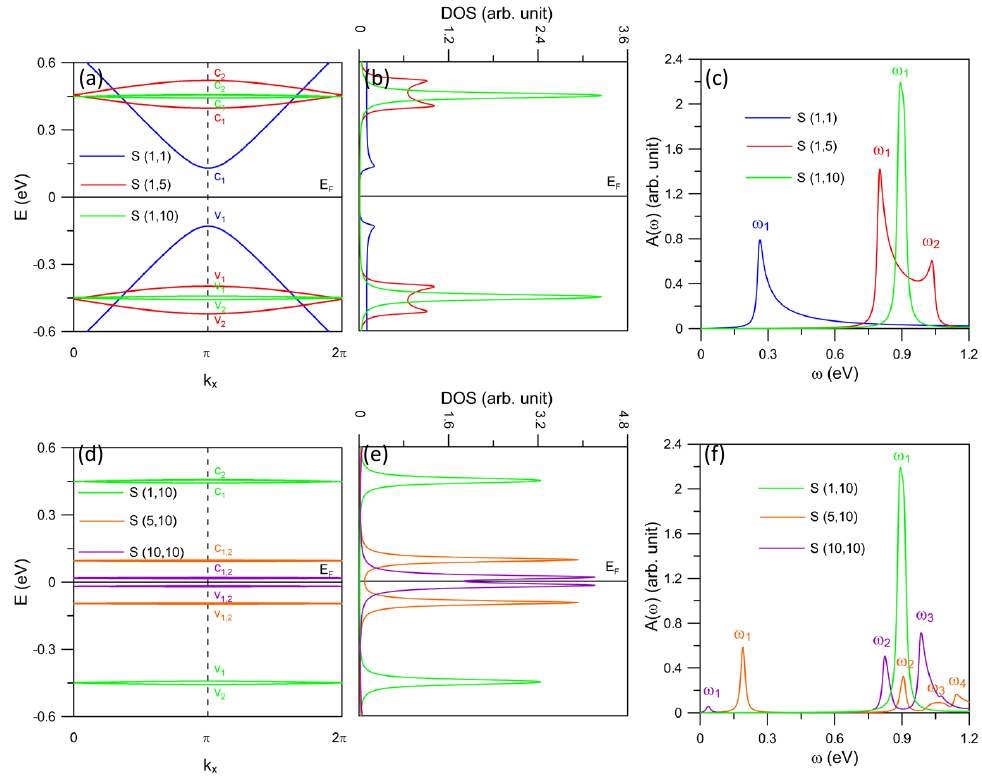
Figure 3. (color online) ( a ) Electronic structure of S- ( n , m ) AGNRs with n = 1 and various m ’s. ( b ) The corresponding DOS and ( c ) absorption spectra. Panels ( d – f ) present similar plots for m = 10 and various n